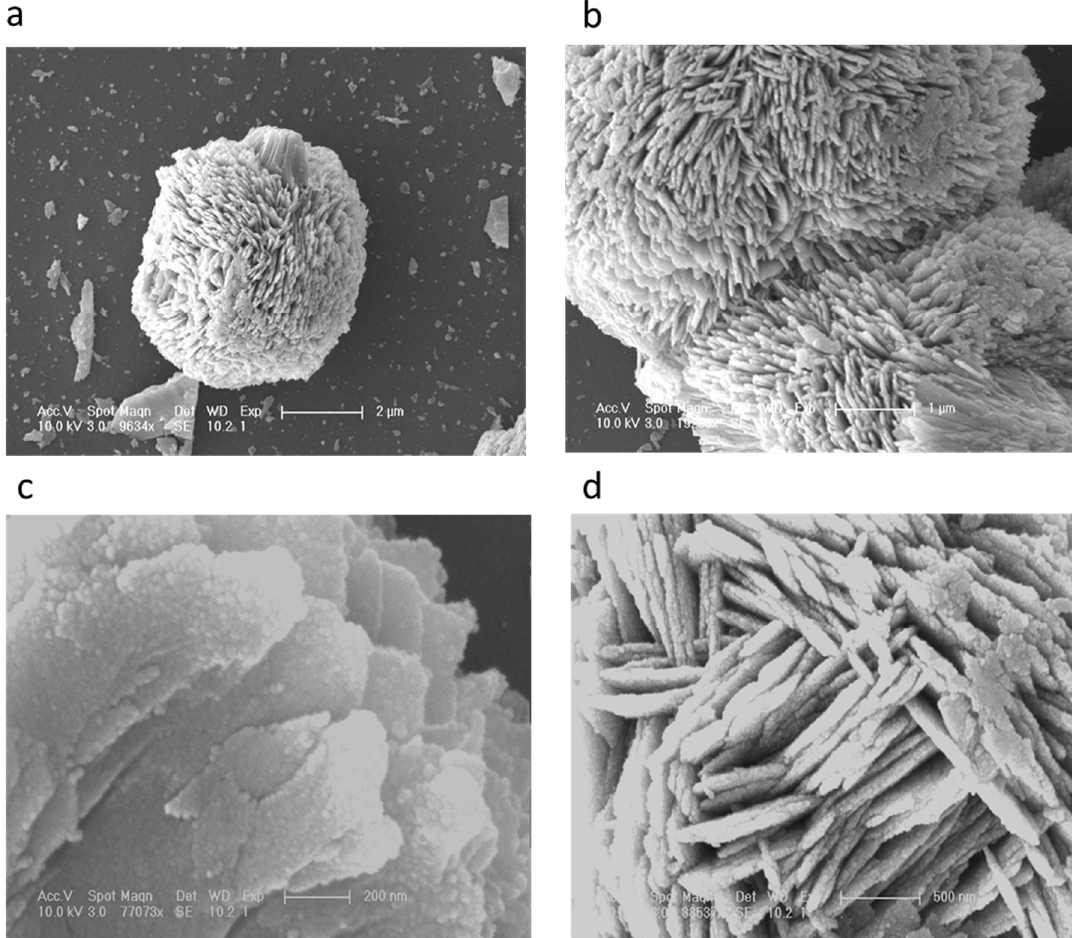
Figure 1. ( a – d ): SEM images of the vitamin B 12 assisted synthesis of CuO nanostructures at different magnifications.